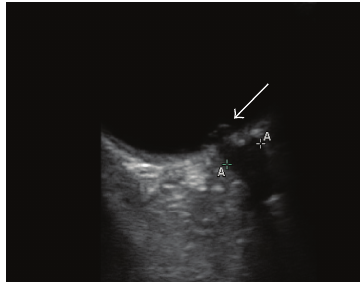
Figure 1: Bedside ocular ultrasound of the right eye demonstrating bulging of the optic nerve cup, indicative of papilledema.